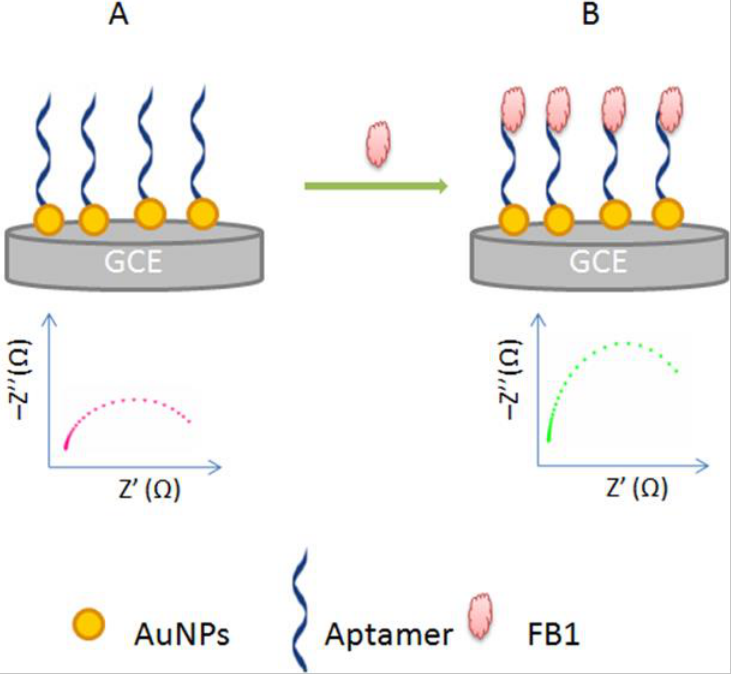
Figure 7. Principle of impedimetric aptasensor for FB1 detection. Niquist plots of the impedimetric aptasensor before ( A ) and after incubation with FB1 ( B ) [86].